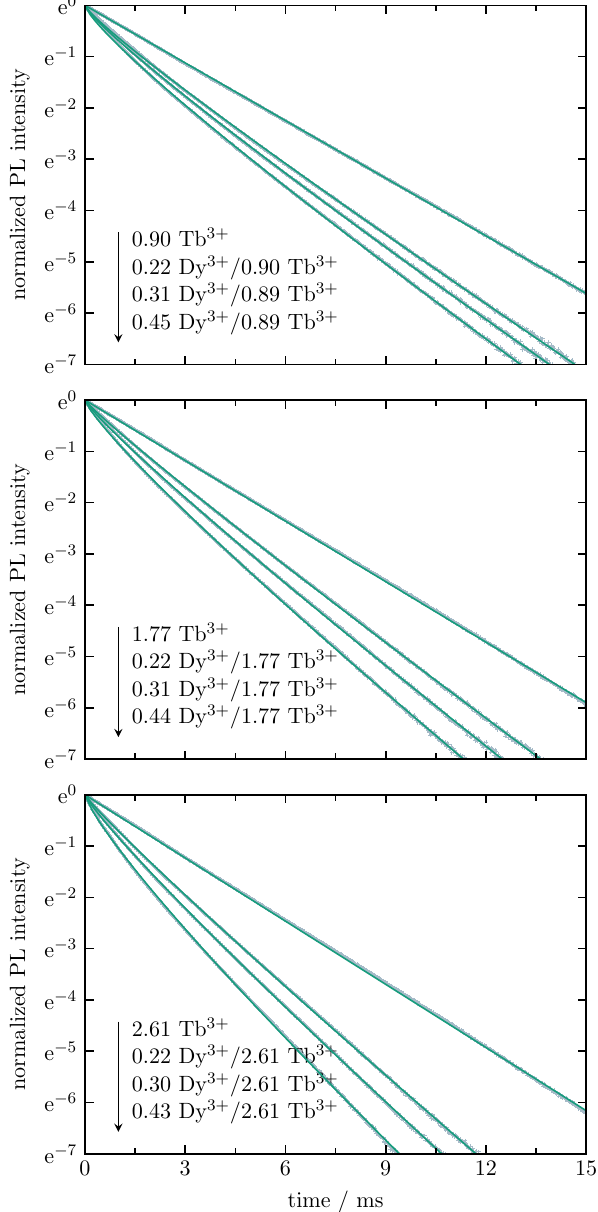
Figure 9. Normalized radiative decay curves of Tb 3 + in Tb 3 + for single- as well as Dy 3 + /Tb 3 + double-doped BaB glasses with varying Tb 3 + and Dy 3 + contents (all values are in at.%), recorded for the Tb 3 + -related 5 D 4 to 7 F 5 transition at 545 nm under 375-nm (Tb 3 + single-doped glasses) and 455-nm (Dy 3 + /Tb 3 + double-doped glasses) excitations. The solid curves (green) represent the best fit on the basis of the Inokuti–Hirayama model. (a)......(b)......(c)......